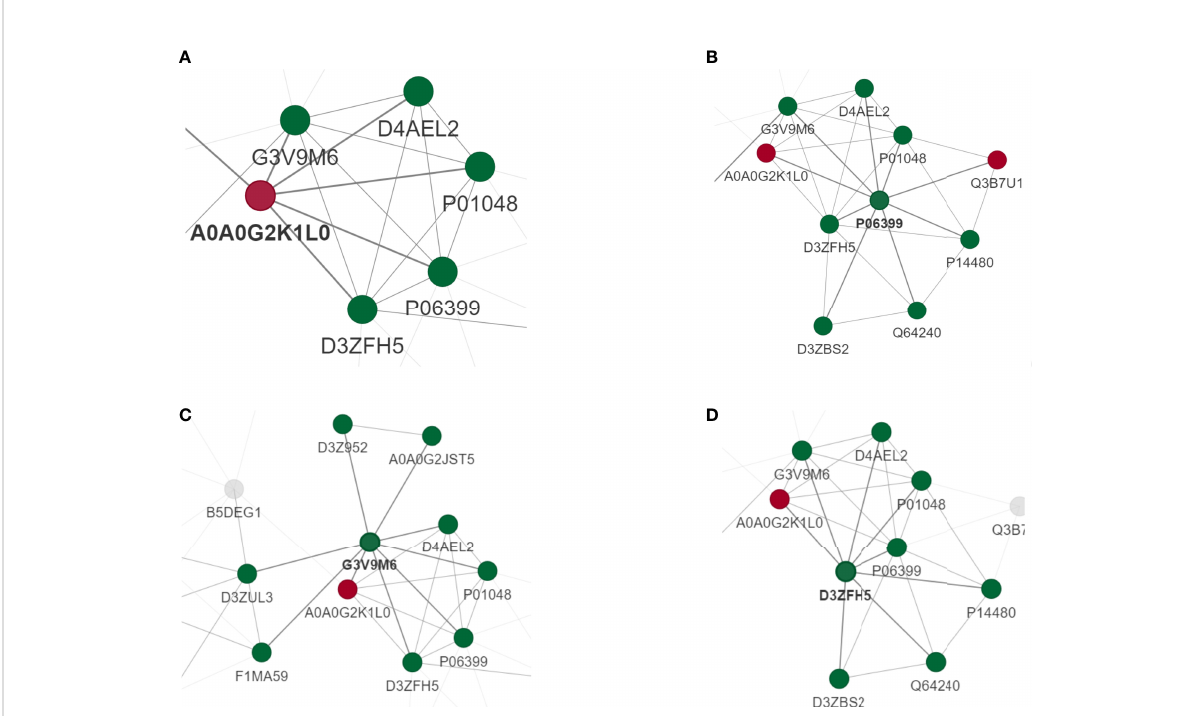
FIGURE 5 PPI analysis of DEPS. MCODE obtained 36 modules and extracted 1 up-regulated DEP module (A) and 3 most signi fi cant down-regulated DEP modules (B – D) .